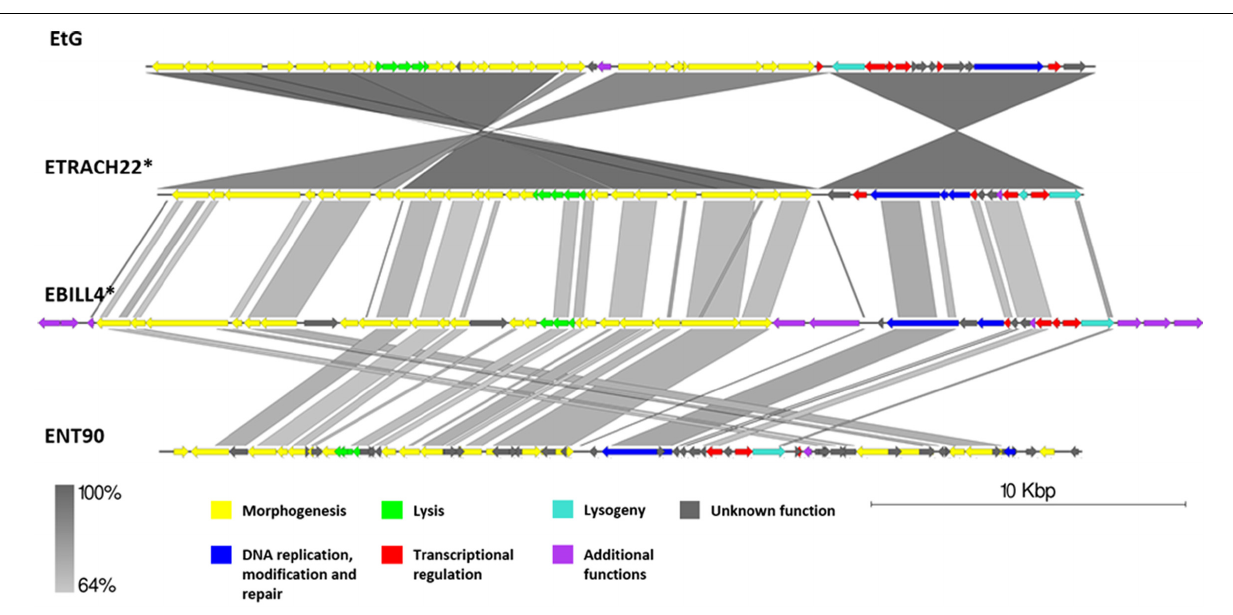
genes from structural module located at both 3 (cid:48) and 5 (cid:48) termini of its physical DNA molecule ( Figure 6